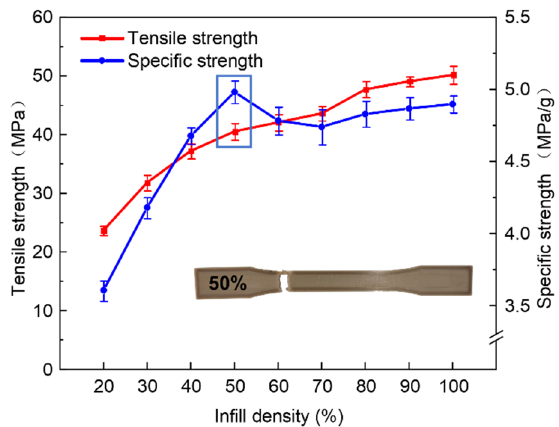
Figure 4. Effects of infill density on tensile strength.